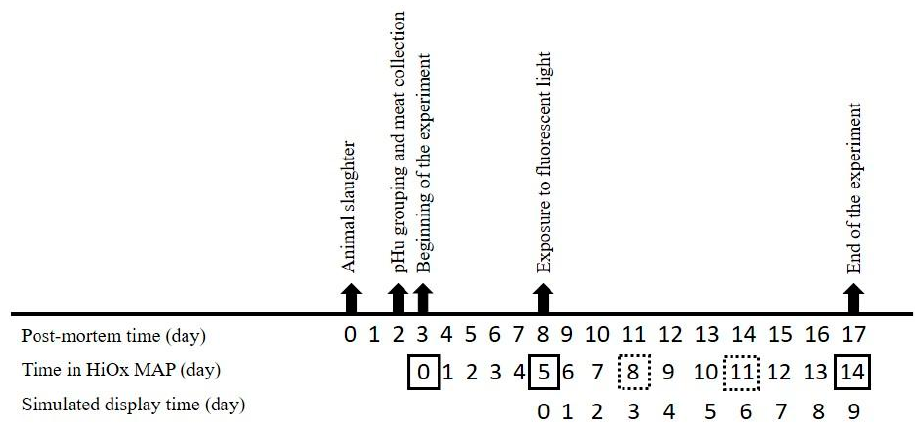
Figure 1. Experimental scheme of the study. HiOx-MAP: high oxygen modified atmosphere packaging (80% O 2 /20% CO 2 ). Boxes with continuous line indicate the days when all measurements were performed. Boxes with dotted lines indicate the days when metmyoglobin reducing ability (MRA), oxygen consumption (OC) and lipid oxidation (TBARS) were not measured.